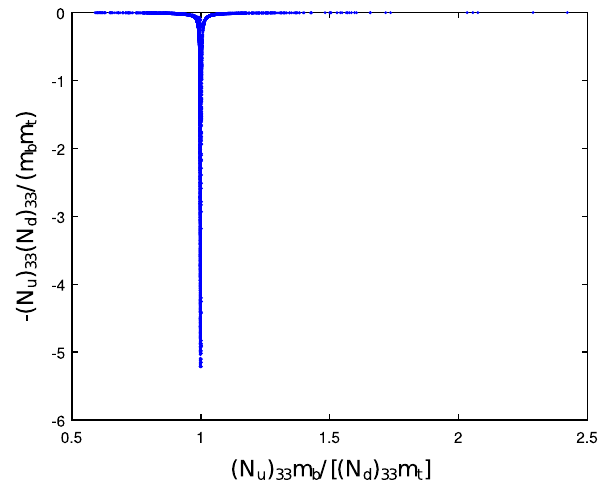
(cid:8) ( m ) versus ( N b m t